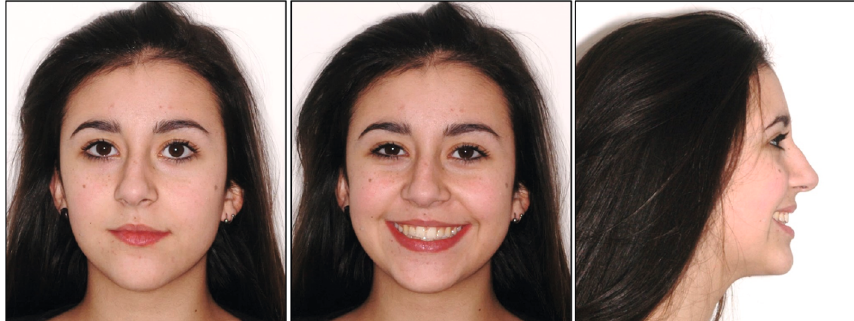
Figure 7: Final facial photographs.